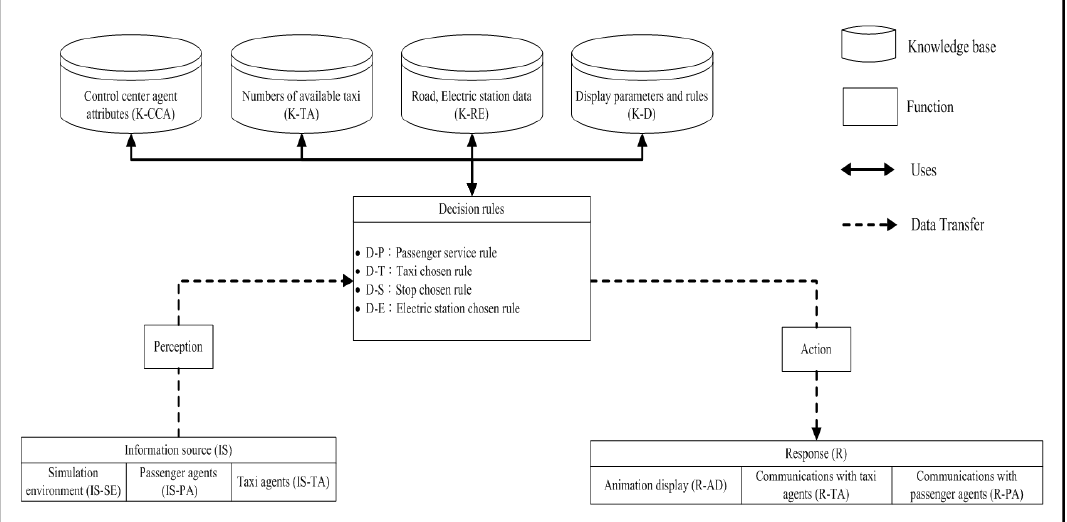
Figure 3 . “ The framework of Control Center